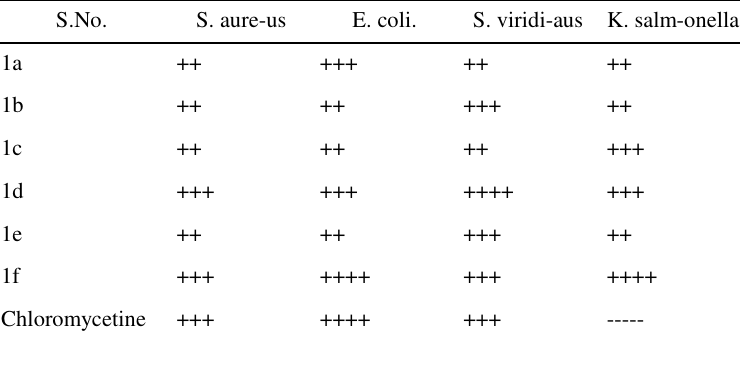
Table-3 Zone of inhibition of compounds 1a-1f